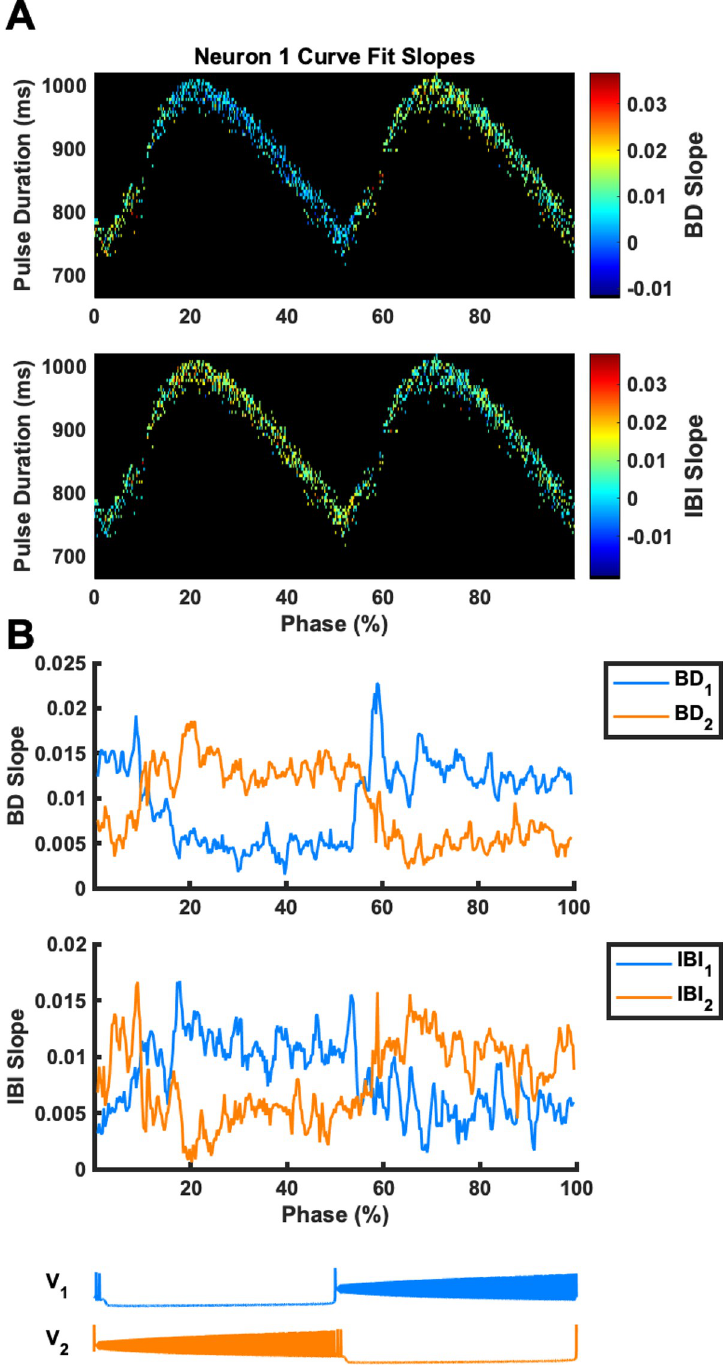
Fig 4. Regression slopes of the relationship between burst duration and burst onset time (BD slope) and between interburst interval and burst onset time (IBI slope) throughout paw-shake-like episodes depend on phase of pulse onset and pulse duration. (A) BD slope and IBI slope for neuron #1 are shown for simulations with 5 to 9 transient paw-shake-like bursts. The color map represents the magnitude of these slopes. (B) BD slope and IBI slope averaged across pulse durations as a function of phase of pulse onset for neuron #1 and neuron #2 and smoothed with a sliding window of phase width 1.25%. A locomotor-like cycle corresponding to the phase of pulse onset is shown at the bottom by traces of neurons #1 and